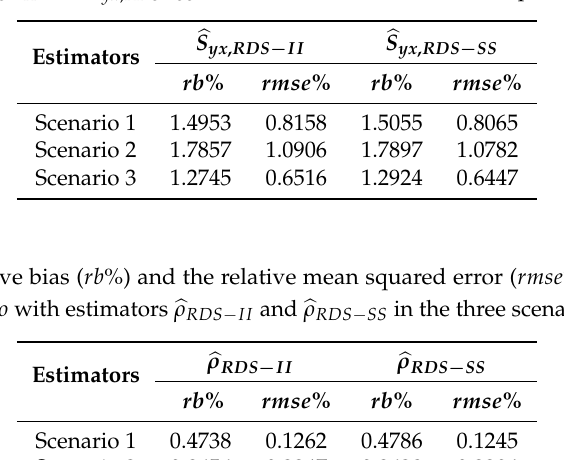
Table 1. Percent relative bias ( rb %) and the relative mean squared error ( rmse %) for estimating S yx with estimators (cid:98) S yx , RDS − II and (cid:98) S yx , RDS − SS in the three scenarios. RDS—respondent-driven sampling.